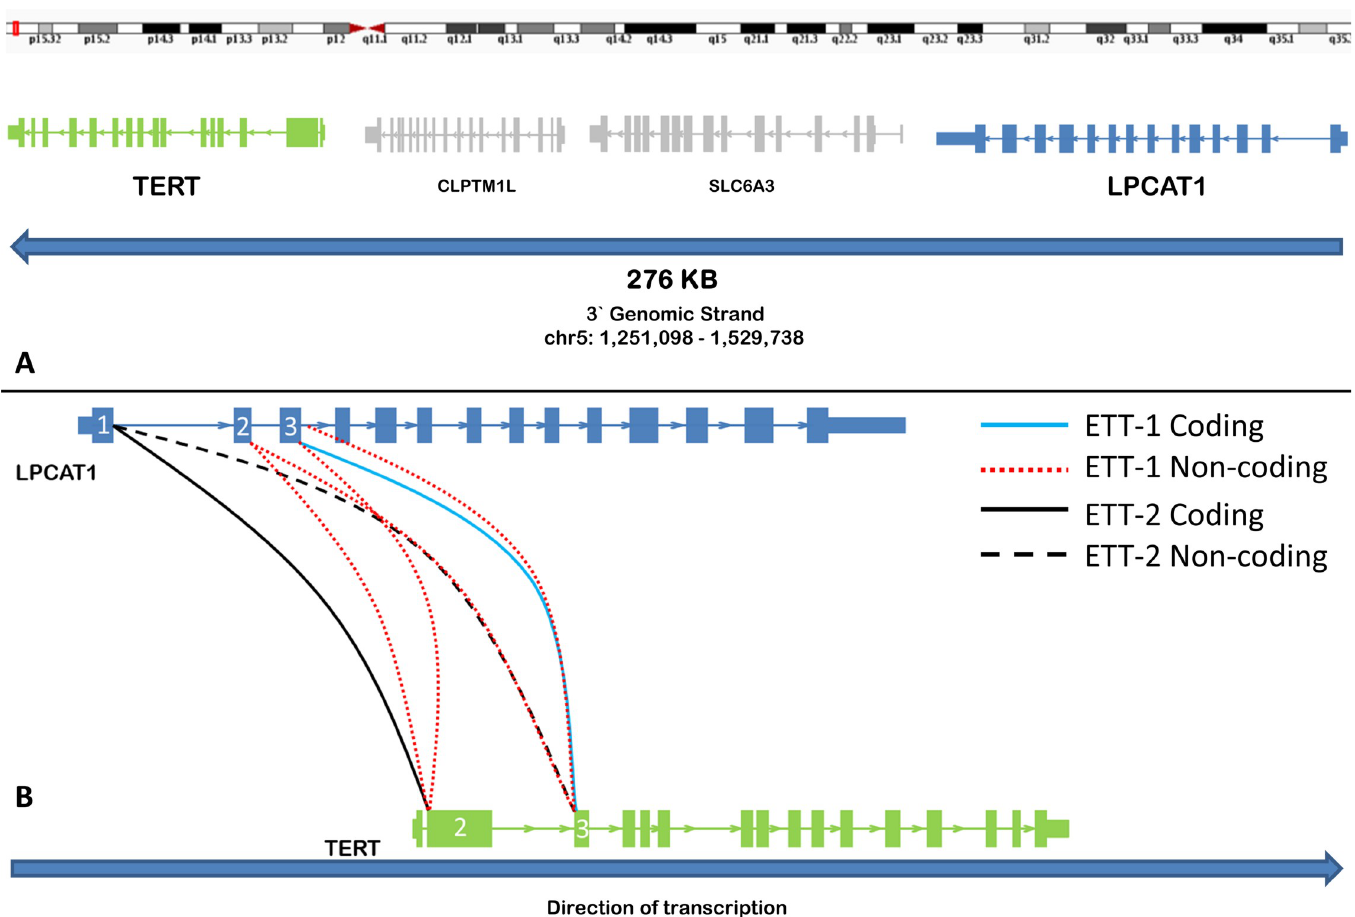
Fig 2. LPCAT1-TERT fusion transcripts identified in two epithelioid trophoblastic tumors. A) The genomic location of LPCAT1 and TERT on chromosome 5 are displayed. Both genes are colinear and are transcribed from the reverse genomic strand. LPCAT1 lies upstream of TERT with two intervening genes positioned between them. B) Alternative LPCAT1-TERT transcript isoforms identified in the two epithelioid trophoblastic tumor cases. Orientation has been flipped from (A) for readability. Solid lines denote exon combinations that retain reading frame and are likely to result in a translated protein product while dotted lines indicate abrogation of reading frame. Both ETT1 and ETT2 produce one transcript that is predicted to form a protein coding LPCAT1-TERT fusion transcript. Distinct exon combinations are observed between the two tumors.